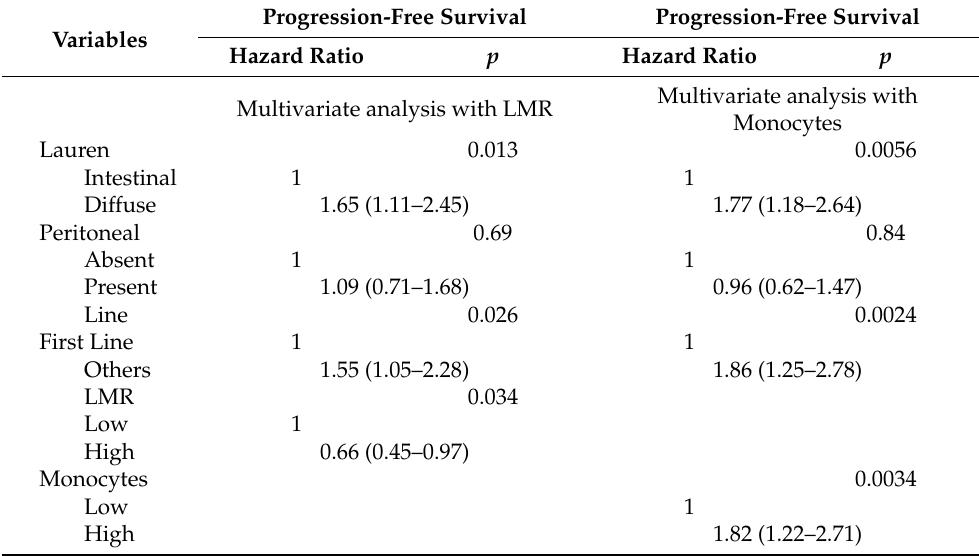
Table 2. Multivariate analysis of independent risk factors for disease progression.